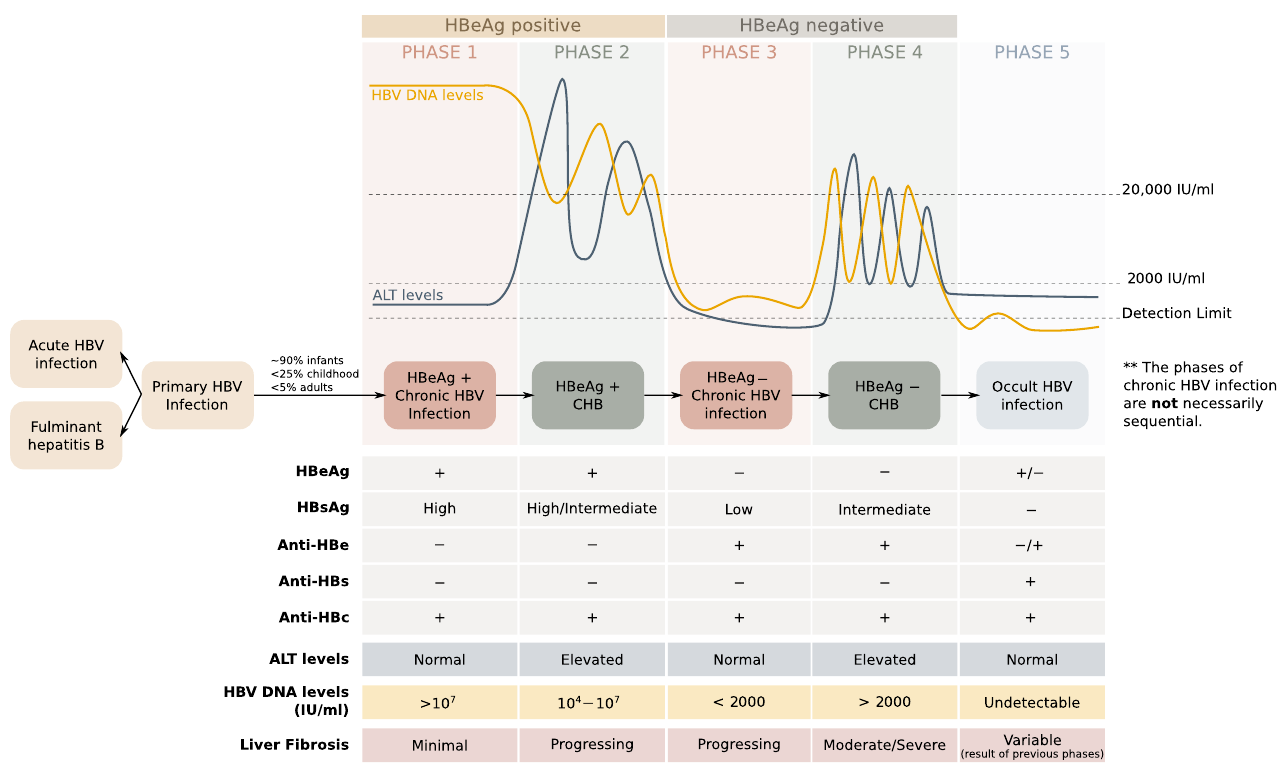
Figure 2. The natural history of chronic hepatitis B is described by five phases—which are not necessarily sequential: the HBeAg positive chronic HBV infection or immune tolerant phase (phase 1), the HBeAg positive chronic hepatitis or immune reactive HBeAg positive phase (phase 2), the HBeAg chronic infection or inactive carrier phase (phase 3), the HBeAg negative or HBeAg negative chronic hepatitis (phase 4) and the Occult HBV infection or HBsAg negative phase (phase 5) [50]. During Phase 1, the HBV DNA levels are very high (>10 7 IU/mL), and HBV integrates parts or the whole of its genome into the host’s hepatocyte genomic DNA as a result of the reverse transcription mediated by the HBV polymerase. The alanine transaminase (ALT) levels are within the normal range, and there is minimal or no liver necroinflammation or fibrosis. Phase 2 is described by high levels of HBV DNA and elevated ALT levels, while there is moderate fibrosis that is accelerating. From this phase most patients transit to Phase 3 after HBeAg seroconversion, while others progress to Phase 4 for many years. Phase 3 is characterized by low (<2000 IU/mL) HBV DNA levels and normal ALT levels. Patients who remain in this phase have a low risk of progression to cirrhosis or HCC but progression to CHB and transition to Phase 4 usually occurs. Phase 4 is described by high levels of serum HBV DNA and elevated ALT levels, while liver necroinflammation and fibrosis are present. Phase 5 is characterized by undetectable levels of HBV DNA and normal ALT levels, while the liver histology and the risk of HCC are sequelae of the previous phases [57]. The general shape of the curves that describe HBV DNA and ALT levels has beeen adapted from